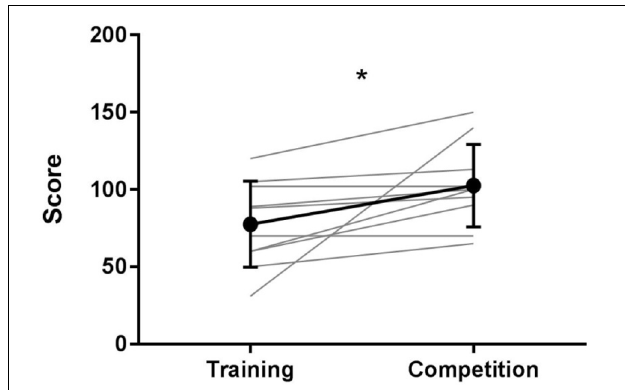
FIGURE 5 | Interpersonal distance of all attacks initiated in training and competition fights. Mean results and standard deviations are presented in bold, individual attacks are presented in light gray circles. The mean and standard deviation is presented. ∗ Indicates a significant fixed effect of condition ( p < 0.05).